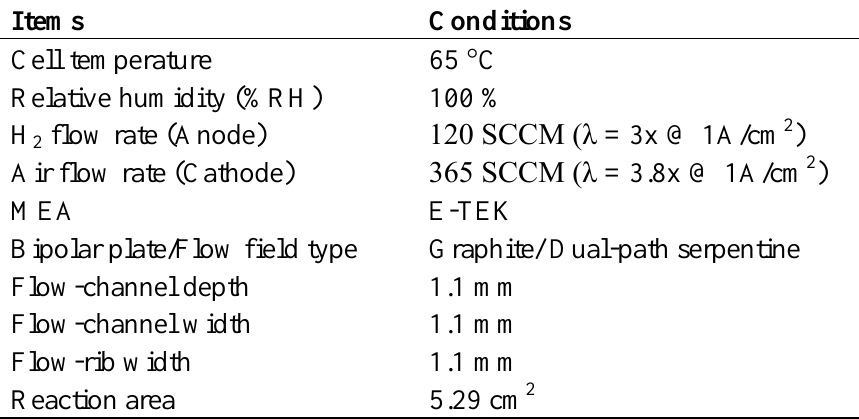
Table 1. Operating conditions and specifications of flow-channel.